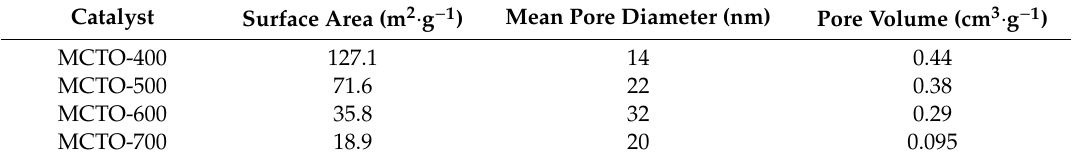
Table 2. Brunauer–Emmett–Teller (BET) specific surface area and pore textures of the samples.